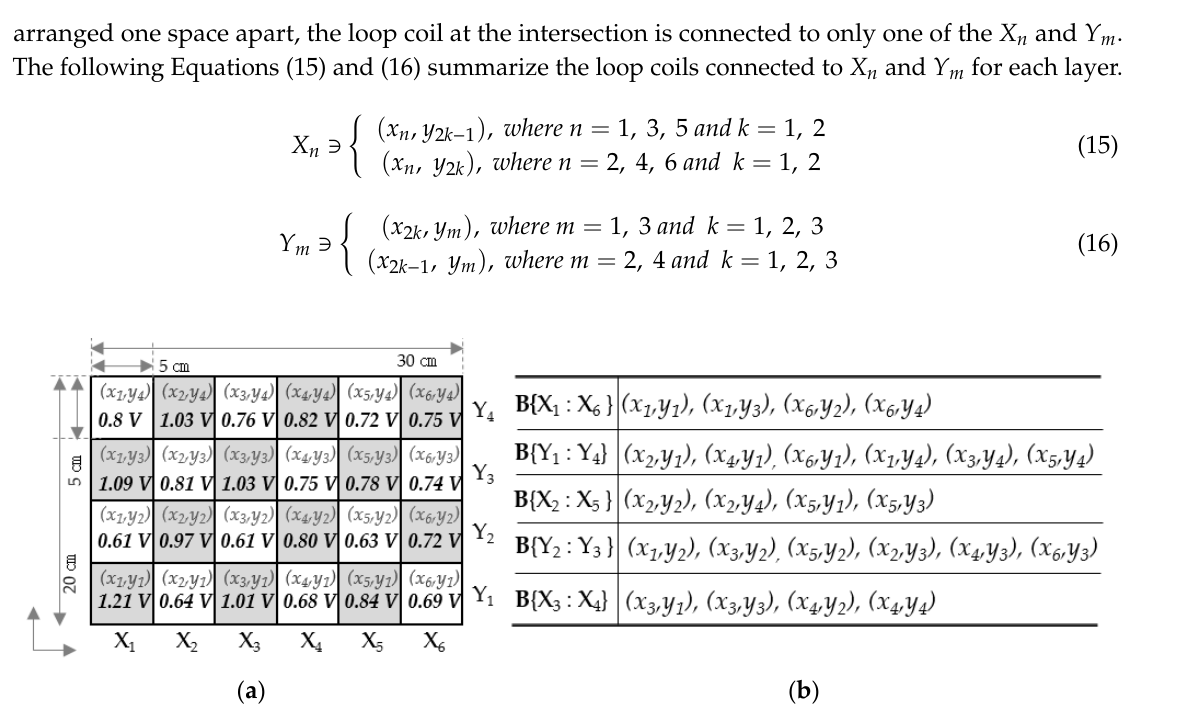
Figure 9. Metal foreign objects used in the experiment.